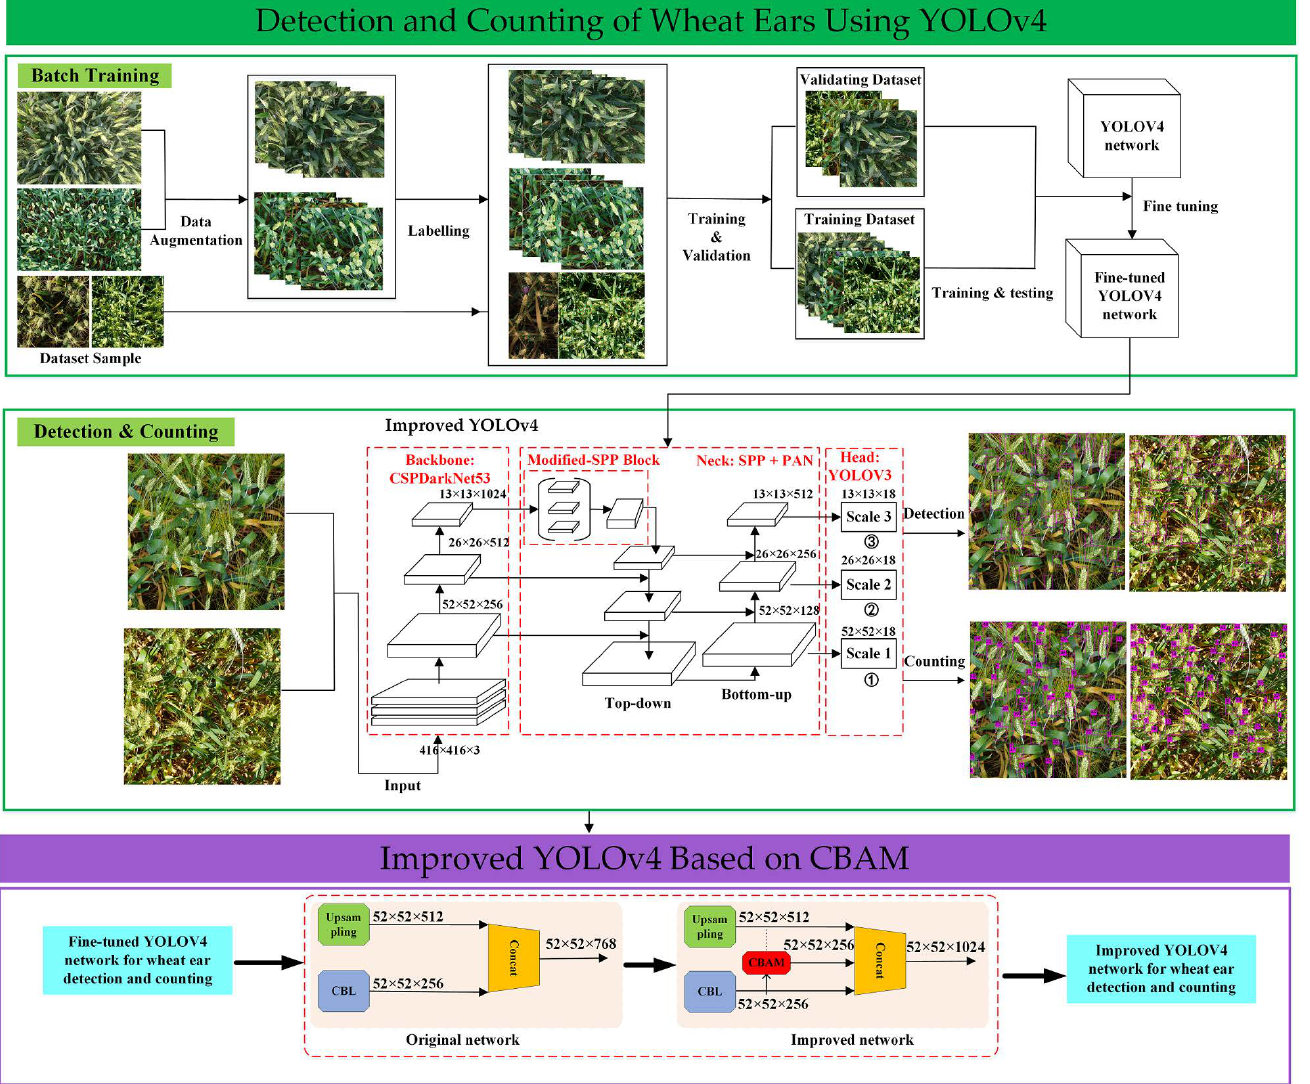
Figure 4. Technical flow chart of wheat ear detection and counting based on improved YOLO